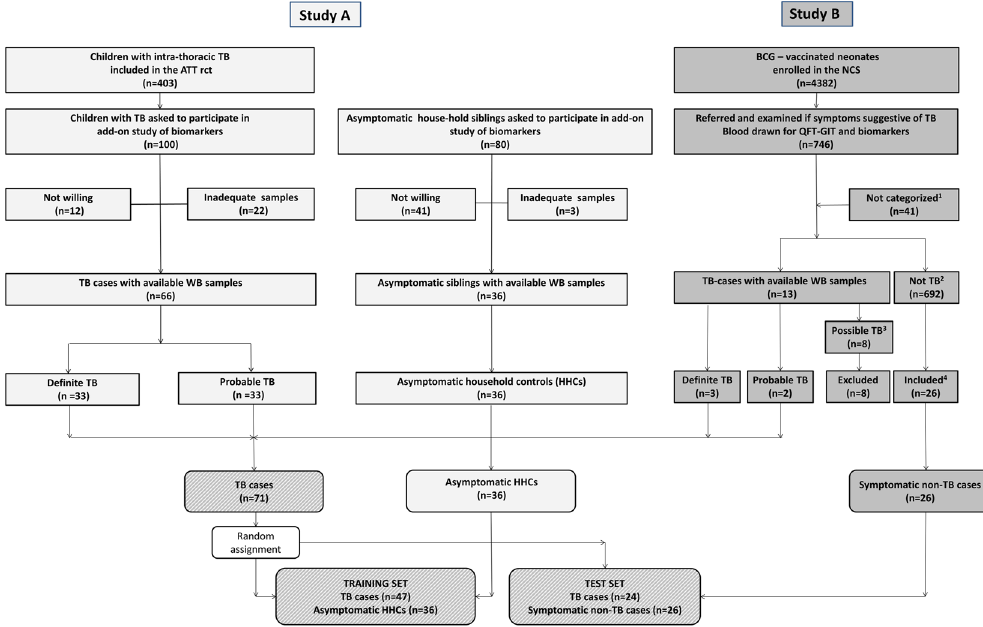
Figure 1. Study flowchart. Selection of participants from study A (Light grey boxes) and study B (Darker grey boxes). Hatched grey boxes: Participants from both studies. Study A was a randomized-controlled trial (rct) of the effect of different micronutrient supplementary as an adjunct to anti-tuberculosis therapy (ATT), carried out from January 2008 to June 2012 in Delhi, India. Study B: A neonatal cohort study (NCS) of BCG- vaccinated neonates randomized to active or passive surveillance for 3 years, in Palamaner Taluk, India, April 2007 to September 2010. 1 Inadequate samples or lost to follow-up. 2 Ninety of 692 were either QFT/TST positive, or both, indicating M. tuberculosis (Mtb) infection. 3 Criteria for possible TB: ≥ 1 sign and symptom for TB, and either; response to treatment/documented exposure/immunological evidence of Mtb -infection, or; X-ray consistent with TB. 4 TB ruled out by clinical, radiological and microbiological